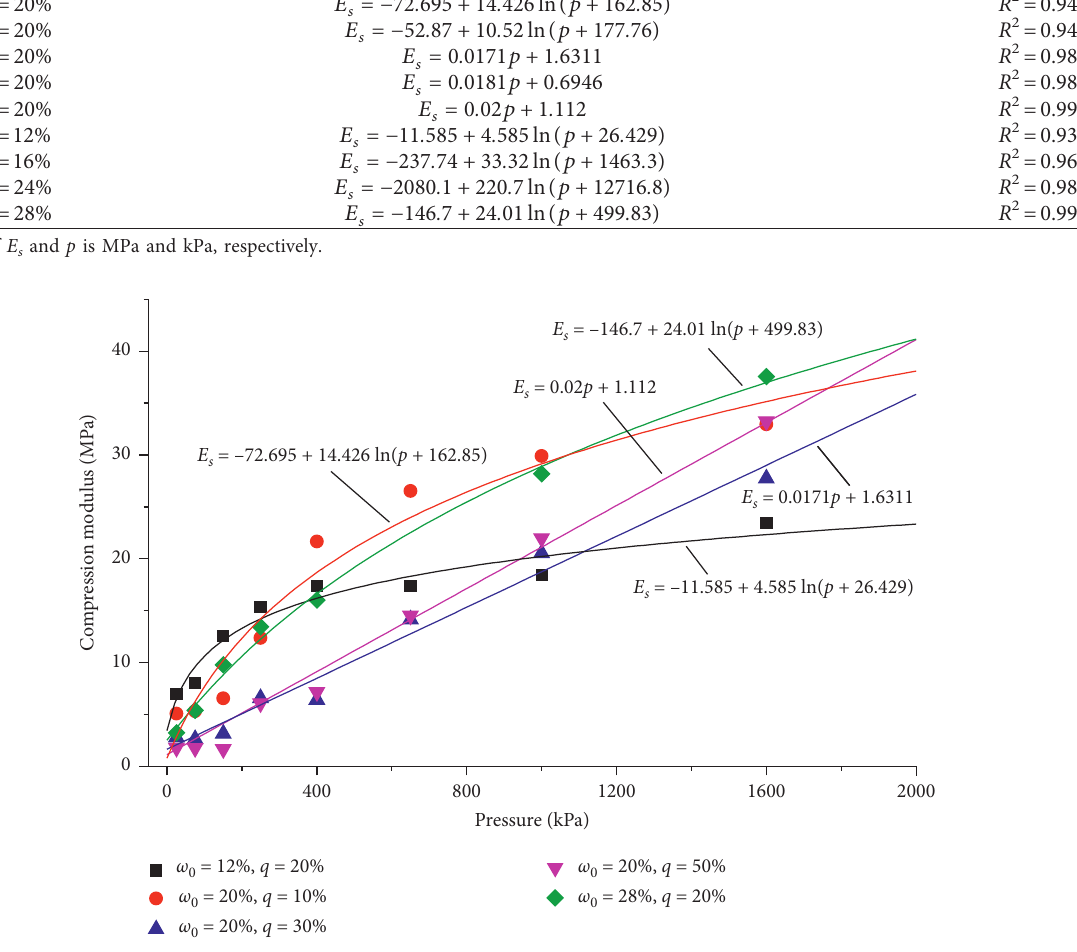
Figure 17: Fitting curves of compression modulus and